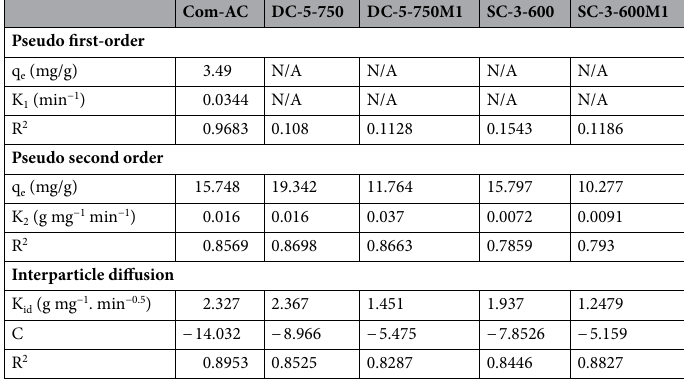
Table 7. Parameters of PFO, PSO kinetics and intraparticle diffusion nitrate model.